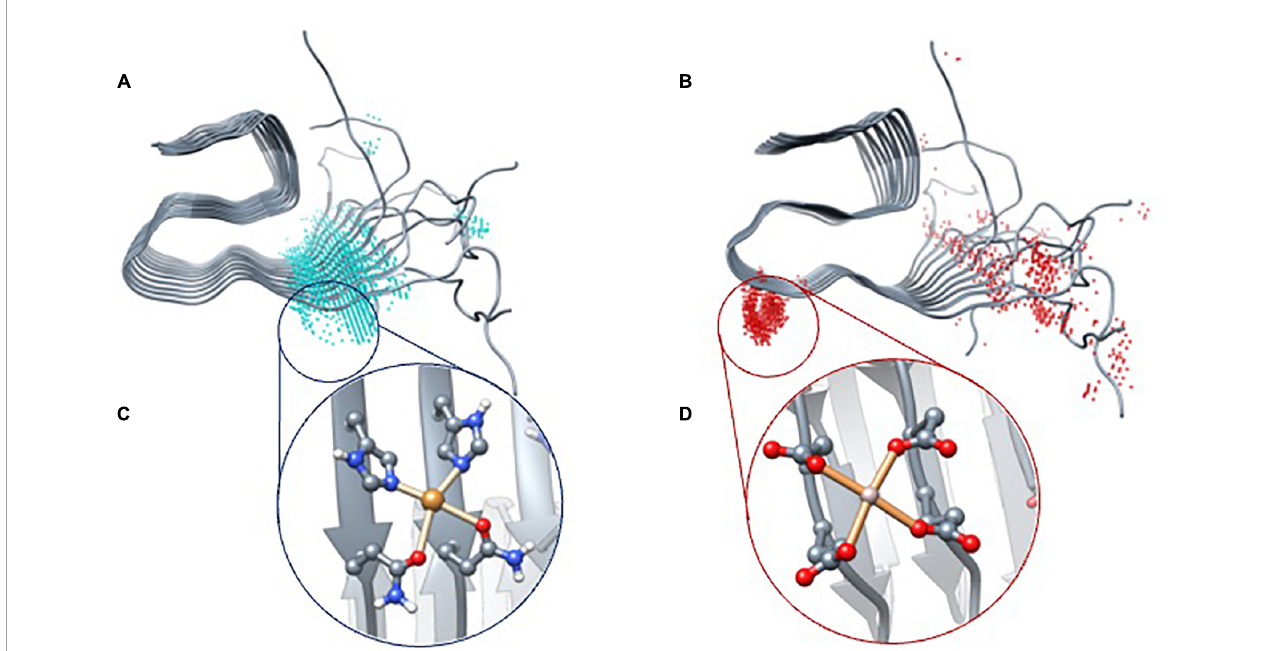
FIGURE3 BioMetAll results of Cu(II) (A) and Al(III) (B) coordination. Once the areas were identified, docking results with Gold software were obtained for Cu(II) (C) and Al(III) (D) .